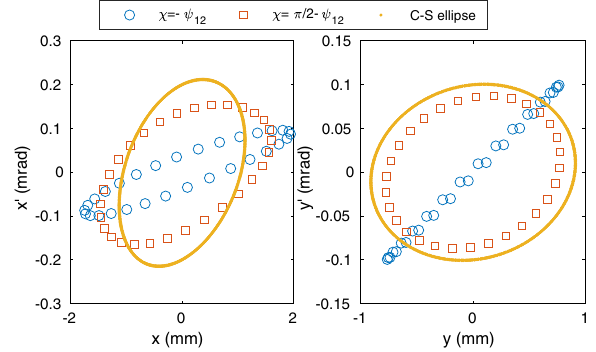
FIG. 3. Phase space plots for simulated closed orbit modulation with the SPEAR3 lattice. Left, horizontal; right, vertical.